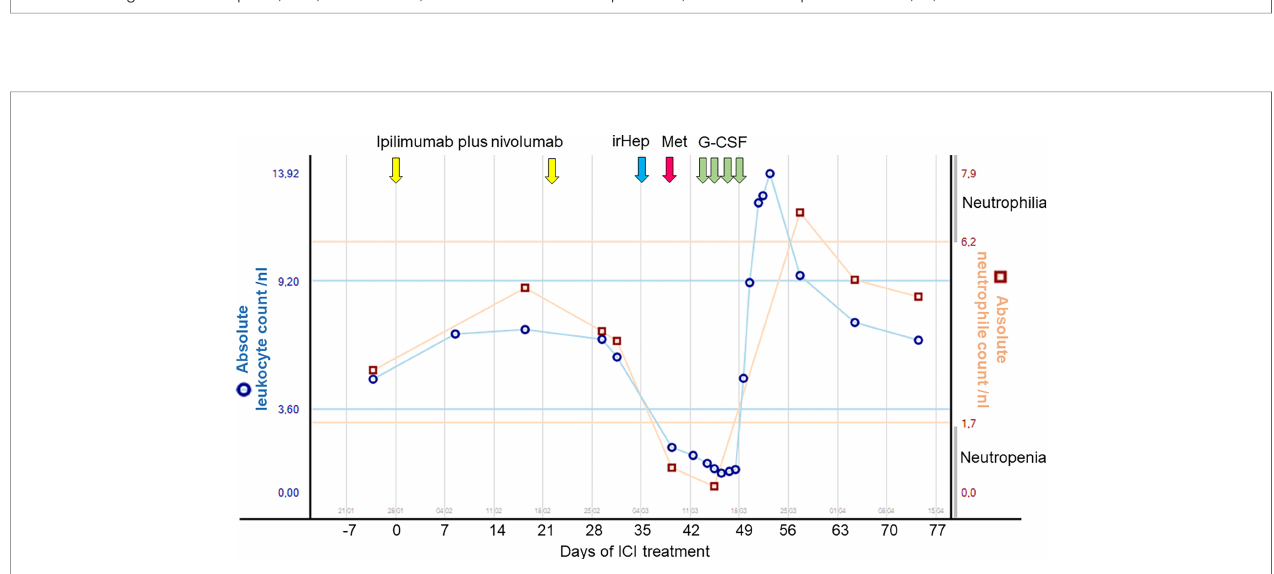
FIGURE 3 | Timeline of patient 7: Neutrophil and leukocyte counts over time following administration of combined ipilimumab – nivolumab and metamizole as well as subsequent treatment interventions. G-CSF, granulocyte colony-stimulating factors; Hep-, hepatitis; ICI, immune checkpoint inhibitor therapy; ir-, immune-related; Met, metamizole; nl,